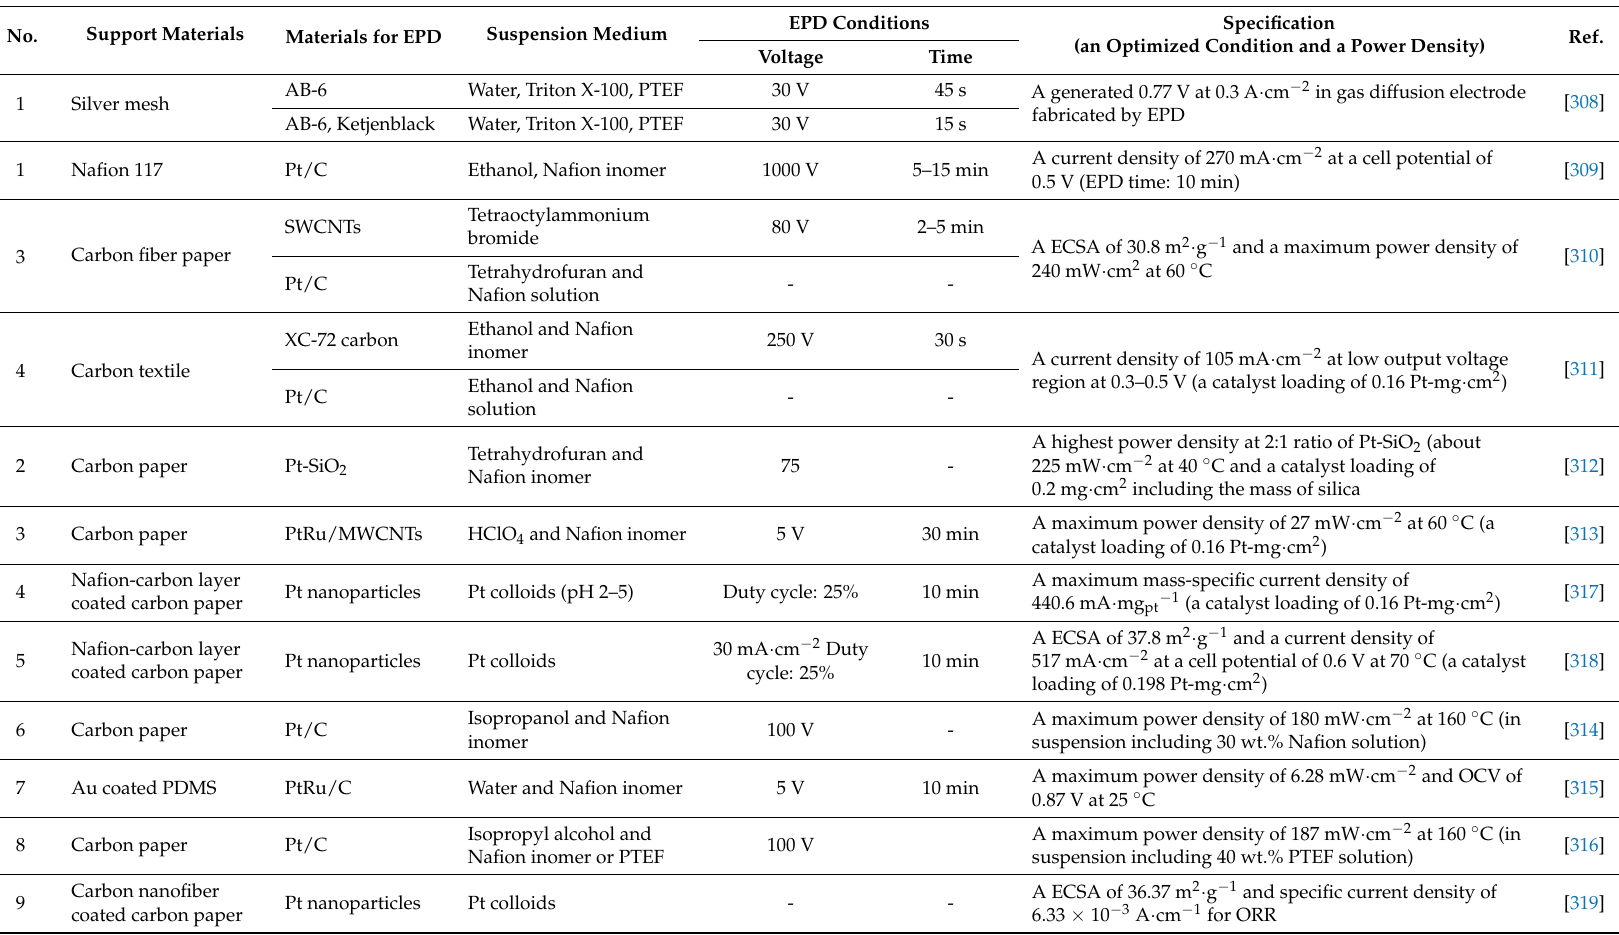
Table A5. Overview of the electrocatalysts fabricated by EPD showing the nanomaterials for electrocatalysis and EPD conditions